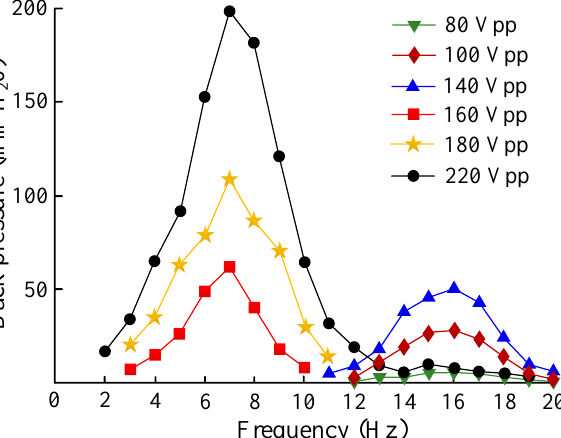
Figure 12. The relationship between the pressure difference, the driving voltage, and the driving frequency.